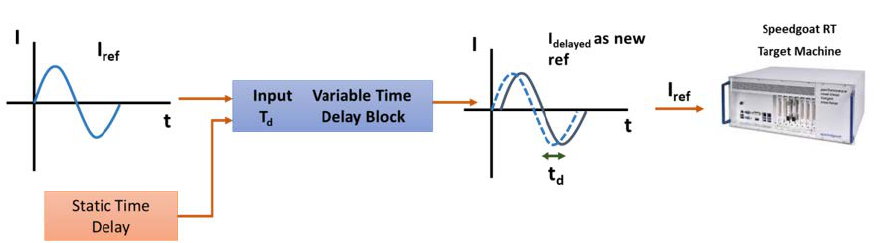
Figure 14. Process flow of static compensation algorithm to control undesired power flow from hardware under test (HUT).